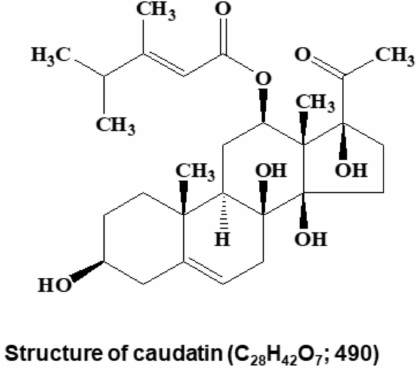
Figure 2. Chemical structure of the CSC inhibitor caudatin isolated from Cynanchum auriculatum